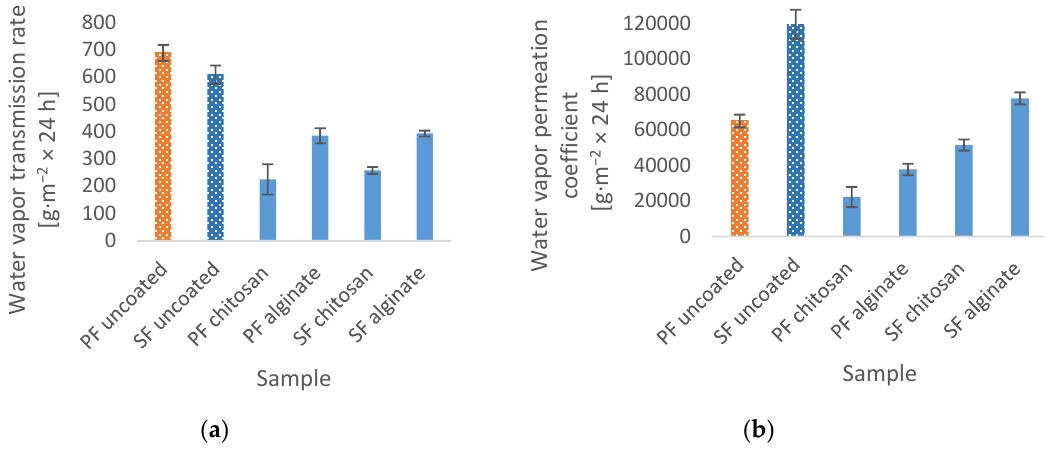
Figure 3. Water-vapor transmission rates ( a ) and water-vapor permeation coefficients ( b ) for uncoated and coated paper samples from primary fiber (PF) and secondary fiber (SF) ( n = 6).